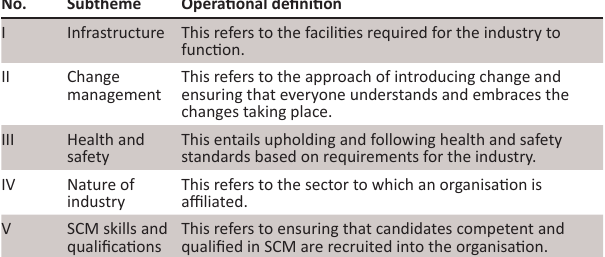
TABLE 3: Operational definitions for the barriers of supply chain